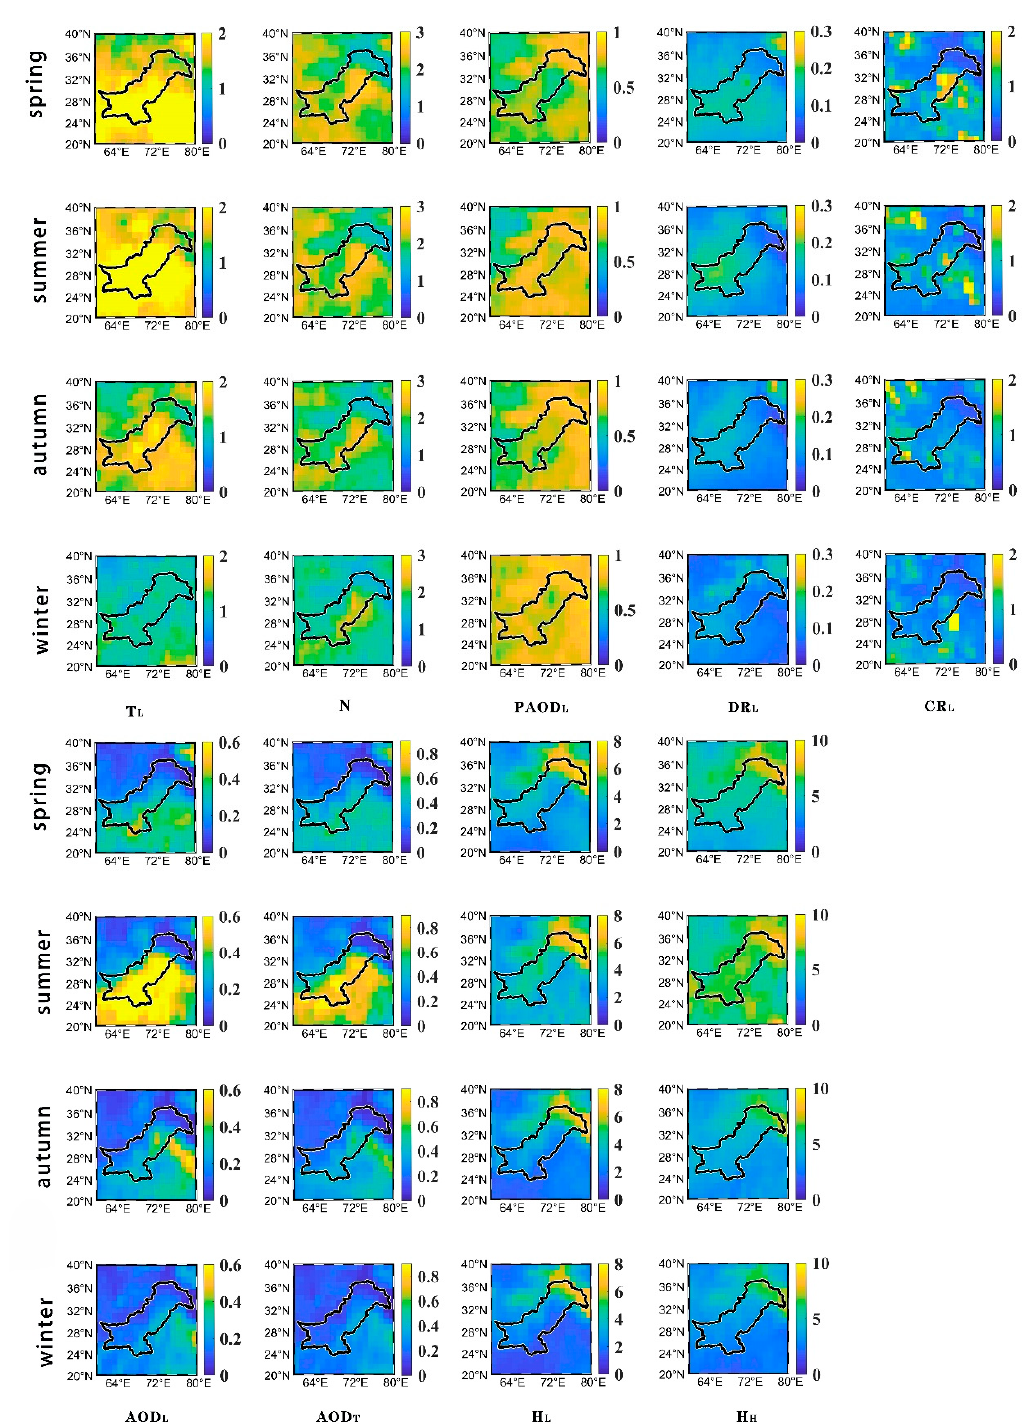
Figure 5. Seasonal spatial distributions of AOD T , AOD L , H L , H H , N, T L , PAOD L , DR L , and CR L over Pakistan during the nighttime.